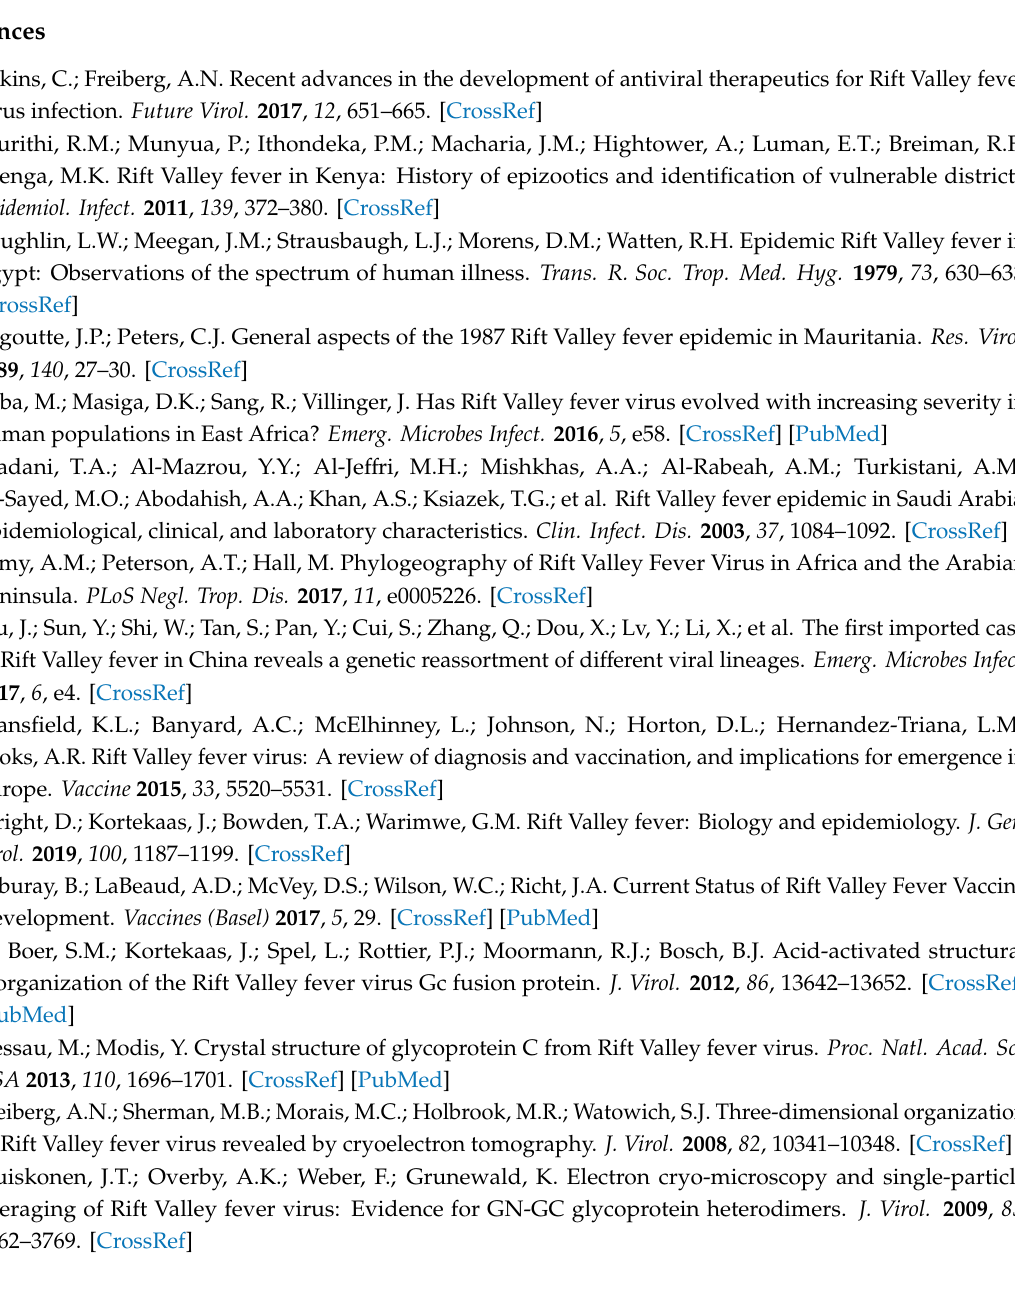
Figure S1: Gating strategy for the collection of antigen-specific memory B cells, Table S1: ELISA analysis of binding activity between Gn and κ -type antibodies expressed by HEK293T cells in 96-well plates, Table S2: ELISA analysis of binding activity between Gn and λ -type antibodies expressed by HEK293T cells in 96-well plates, Table S3: Germline analysis of isolated NAbs to RVFV